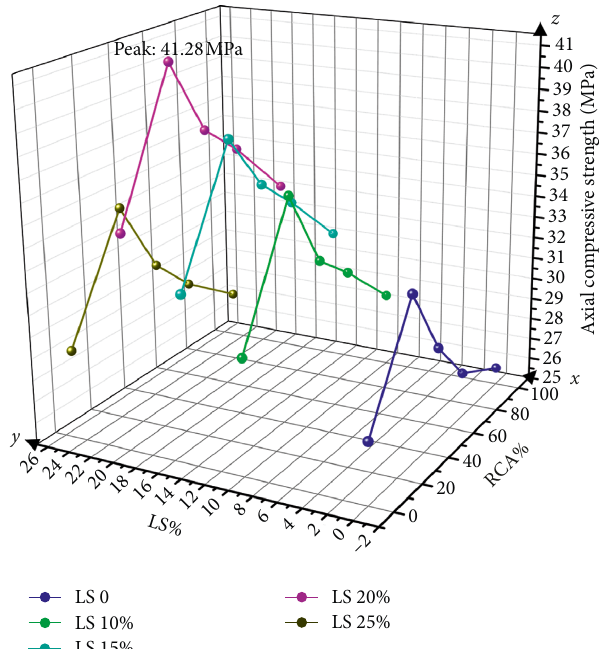
Figure 3: The effect of RCA and LS on the axial compressive